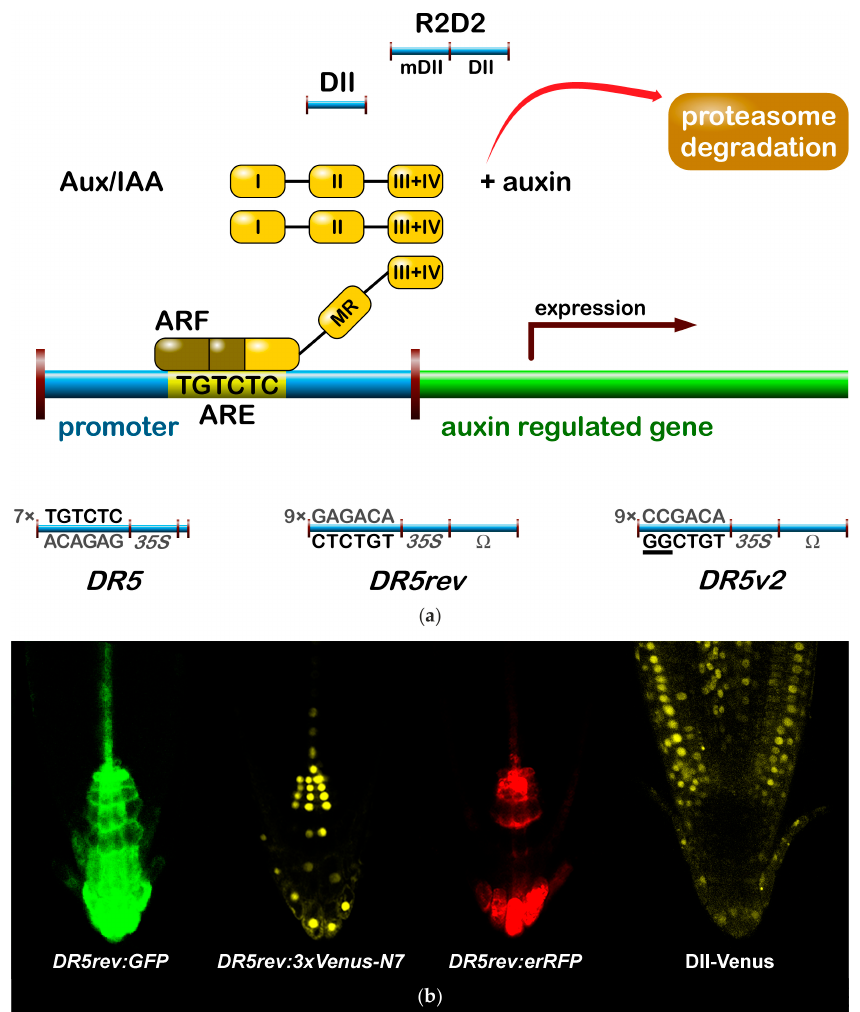
Figure 1. Indirect auxin reporters. ( a ) DR5 reporters were derived from auxin response element (ARE) sequence for binding of ARF transcription factors in auxin responsive promoters. ( b ) The expression of DR5rev:GFP , DR5rev:3xVenus-N7 and DR5rev:erRFP reflects similar auxin signalling output in Arabidopsis root tip. Degradation based reporters DII and R2D2 contain degron domain from Aux/IAA repressors leading to ubiquitination and degradation in the presence of auxin. They represent auxin signalling input. 35S , CaMV35S minimal promoter; ARE, auxin response element; ARF, AUXIN RESPONSE FACTOR; Aux/IAA, AUXIN/INDOLE-3-ACETIC ACID; GFP, green fluorescent protein; RFP, red fluorescent protein; Venus, yellow fluorescent protein; and, Ω , tobacco mosaic virus leader sequence.